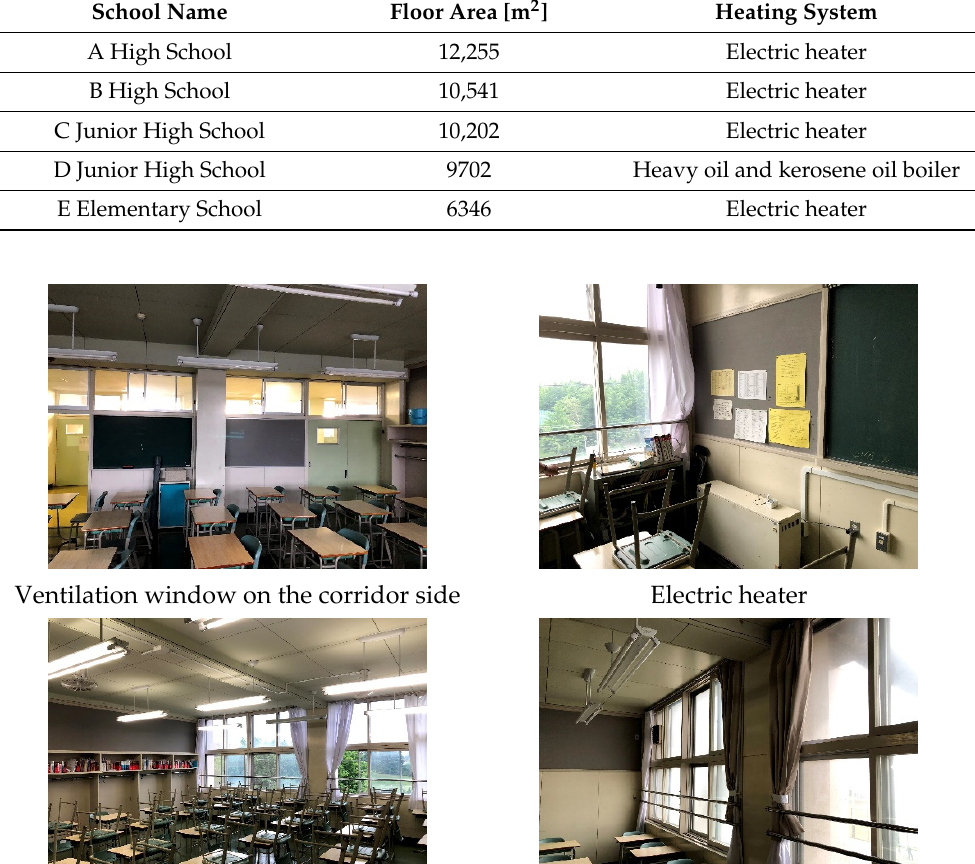
Table 1. Target facilities.